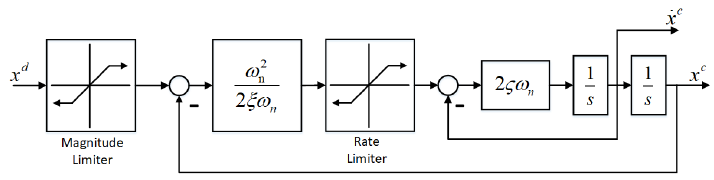
Figure 1. The structure of the constrained command